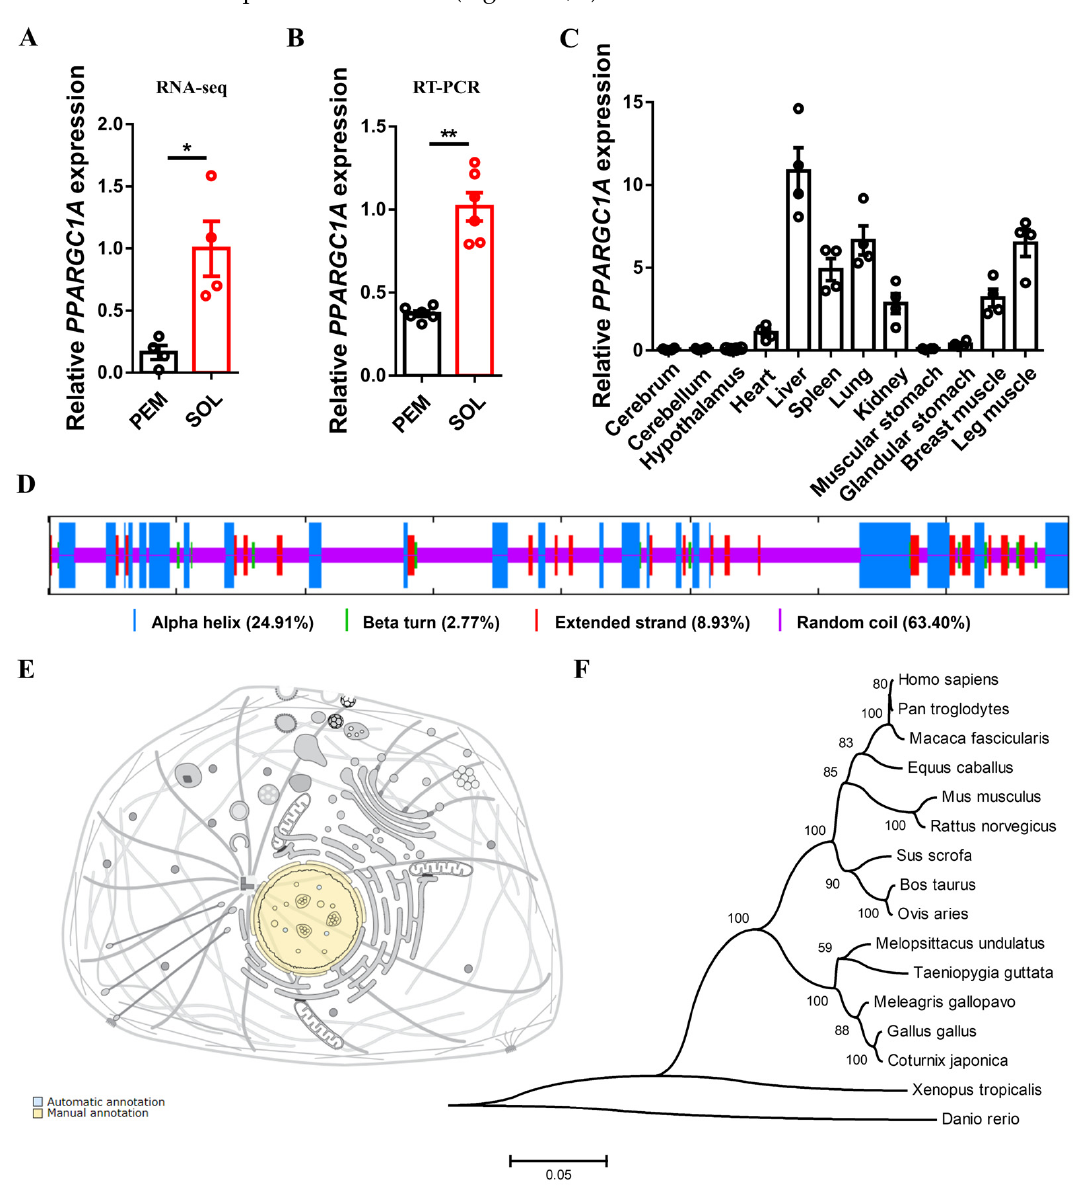
Figure 1. Identification of chicken PPARGC1A . ( A , B ), relative PPARGC1A expression in pectoralis major (PEM) and soleus (SOL) of 7-week-old Xinghua chicken detected by RNA-seq ( A ) and qPCR ( B ). ( C ), tissue expression profiles of PPARGC1A . The horizontal axis and vertical axis indicate different tissues and their relative expression values, respectively. ( D ), secondary structure of PPARGC1A protein predicted by SOPMA software (https://npsa-prabi.ibcp.fr/cgi-bin/npsa_automat.pl?page=npsa_sopma.html, accessed on 1 February 2022). ( E ), subcellular location of PPARGC1A protein annotated by UniProt Knowledgebase (https://www.uniprot.org/, accessed on 1 February 2022). ( F ), phylogenetic tree of chicken PPARGC1A aligned amino acid sequences. Results are presented as mean ± SEM. In panels ( A , B ), statistical significance of differences between means was assessed using paired t -tests. (* p < 0.05; ** p < 0.01).